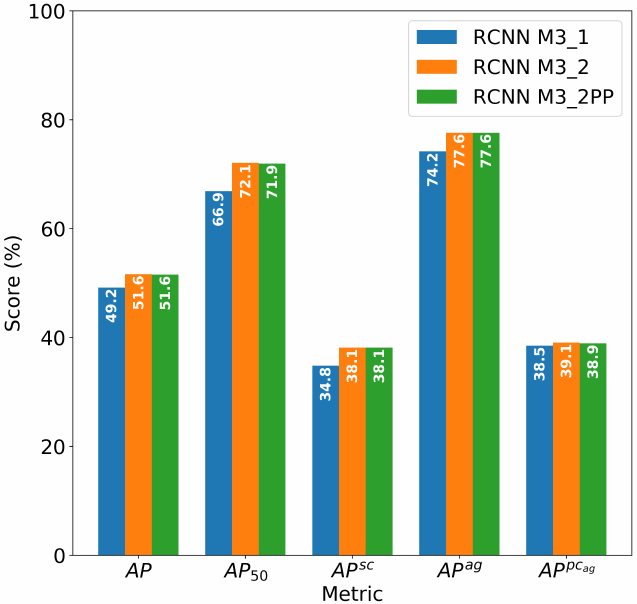
Figure 3. Comparison between Mask-RCNN-based methods developed in this